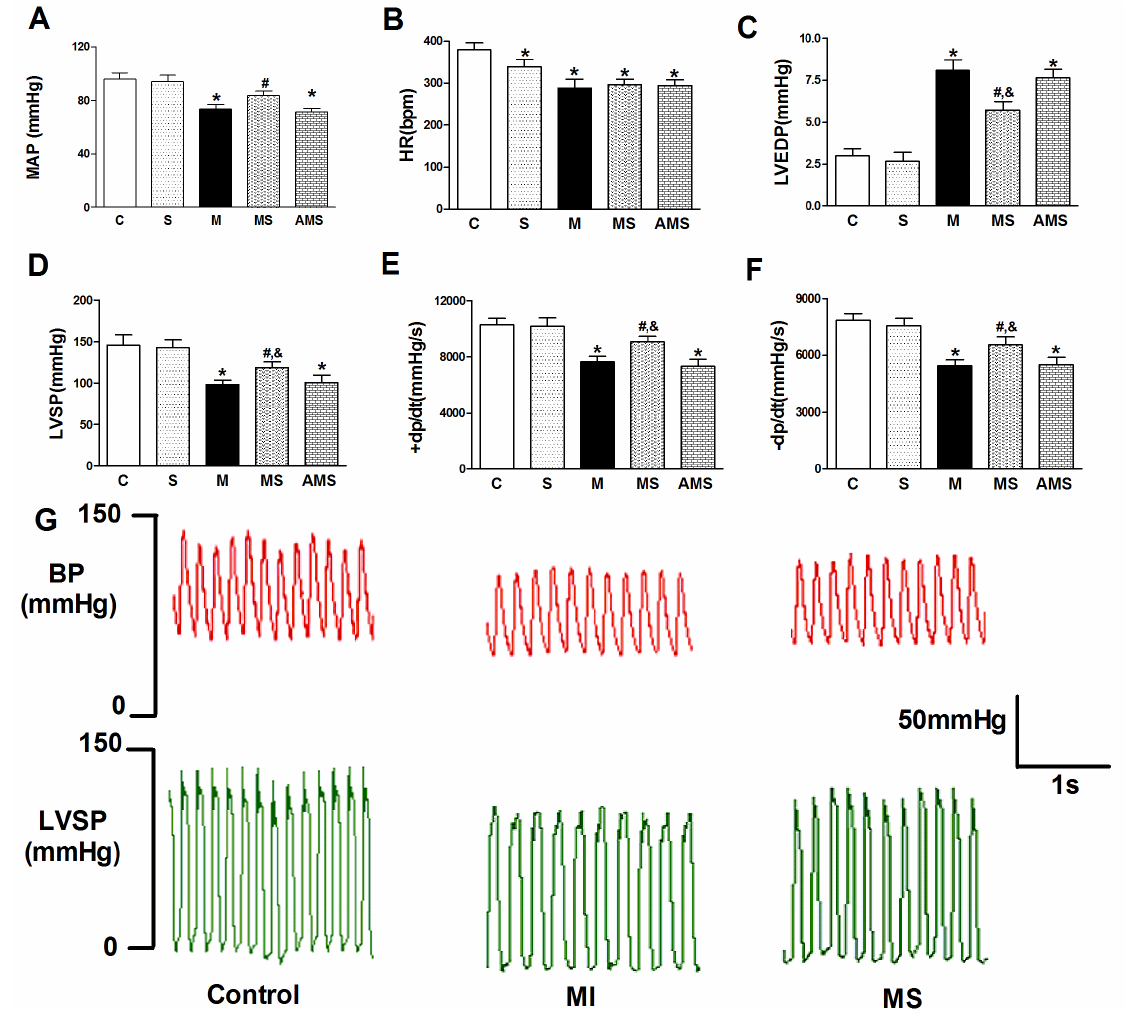
Figure 2. Effect of vagal nerve stimulation (VNS) on cardiac function. ( A ) MAP, mean arterial pressure; ( B ) HR, heart rate; ( C ) LVSP, left ventricular systolic pressure; ( D ) LVEDP, left ventricular end-diastolic pressure; ( E ) +d P /d t = maximal slope of systolic pressure increment; ( F ) − d P /d t = maximal slope of diastolic pressure decrement; ( G ) Raw pressure data collected in C, M and MS group at the end of experiment. Data are the mean ± SEM ( n = 12). * p < 0.05 compared with control (C); # , & p < 0.05 compared with M and AMS,